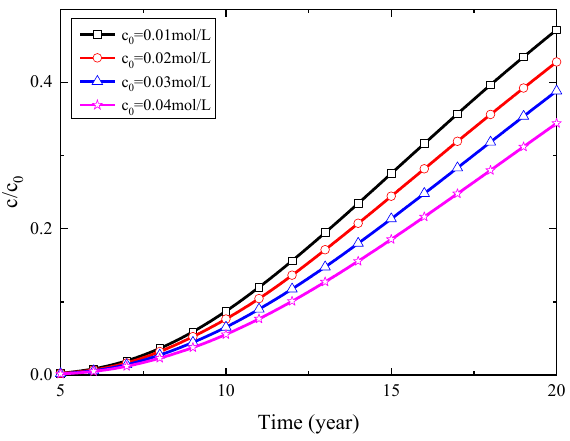
Figure 5: Distribution of pollutant concentration with time at the lower boundary.